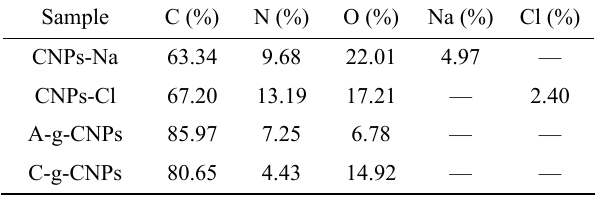
calculated from the XPS analyses.